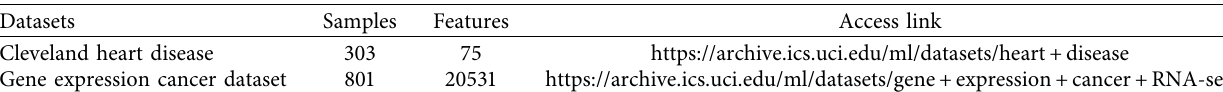
Table 2: Summary of medical